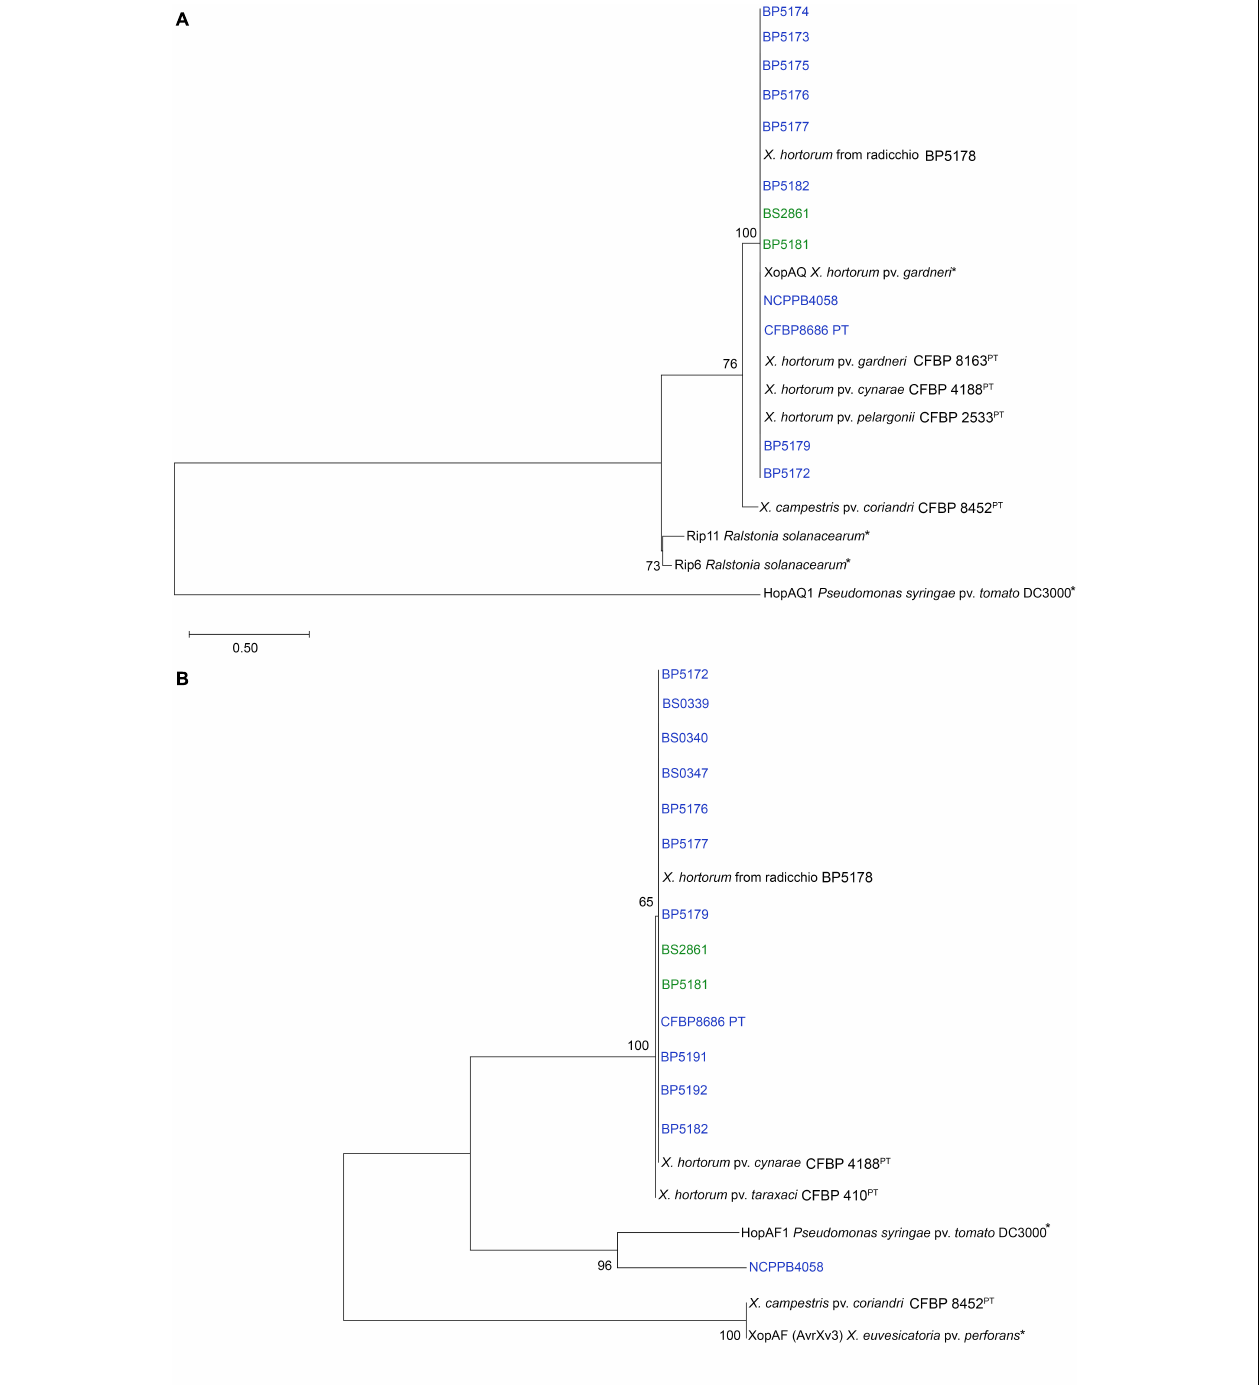
Frontiers in Microbiology |